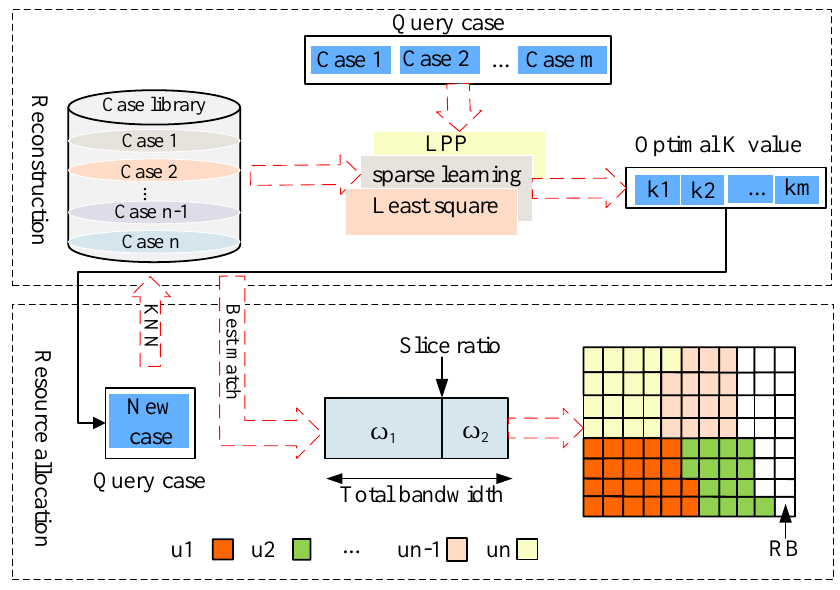
Figure 3. Flowchart of the O-KNN